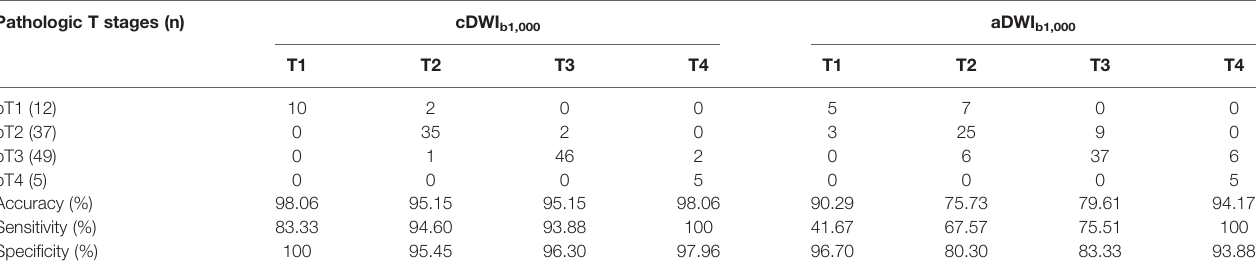
TABLE 2 | T staging of rectal cancer using cDWI b1,000 and aDWI b1,000 images. Pathologic T stages